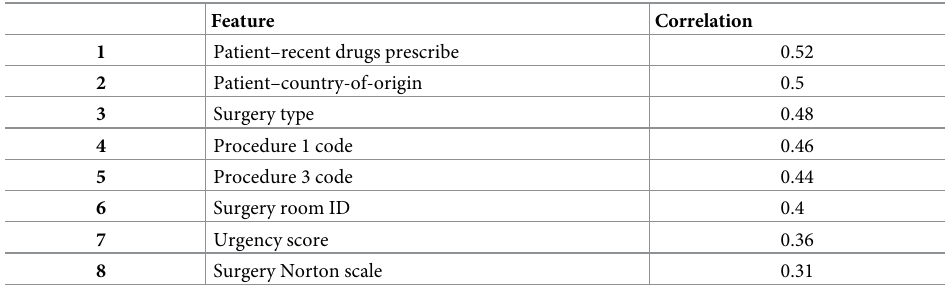
Table 9. Pearson correlation